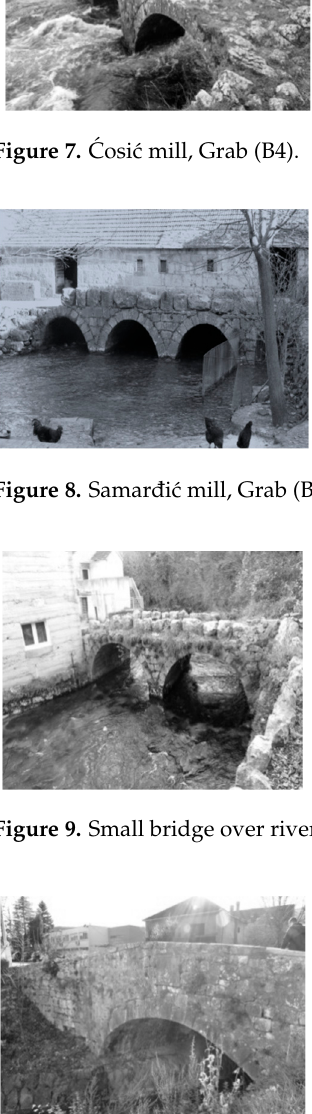
Figure 10. Goru č ica, Sinj (B7).